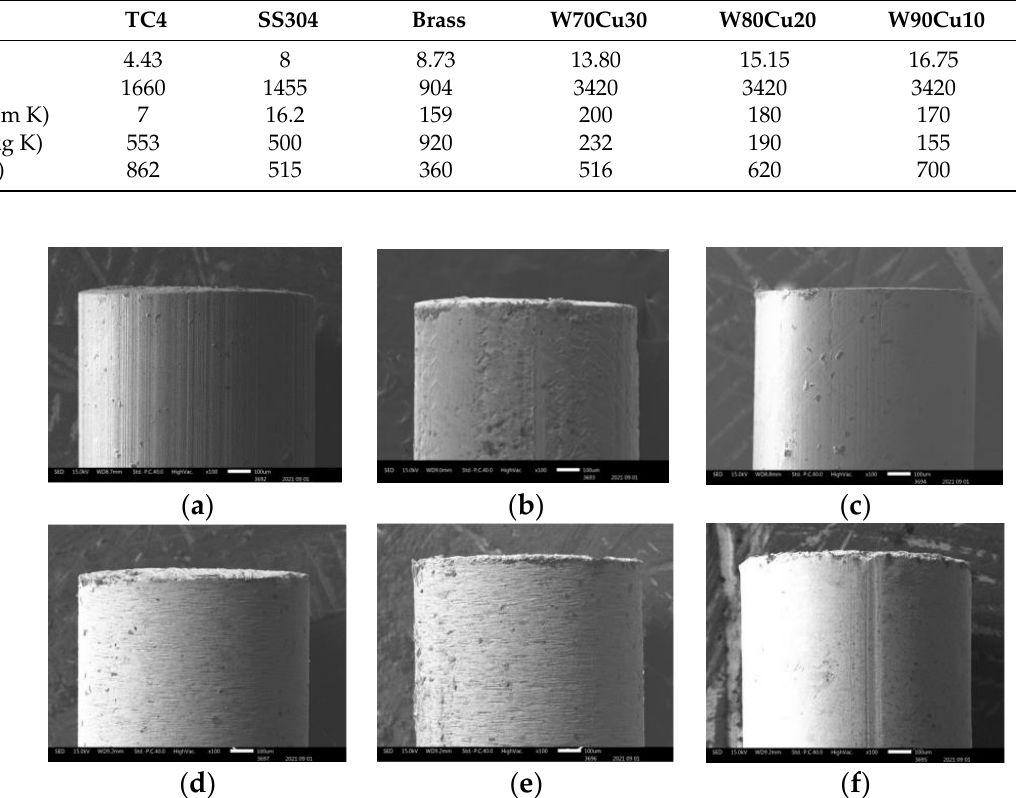
Figure 3. Scanning electron microscopy (SEM) picture of six different electrodes before machining: